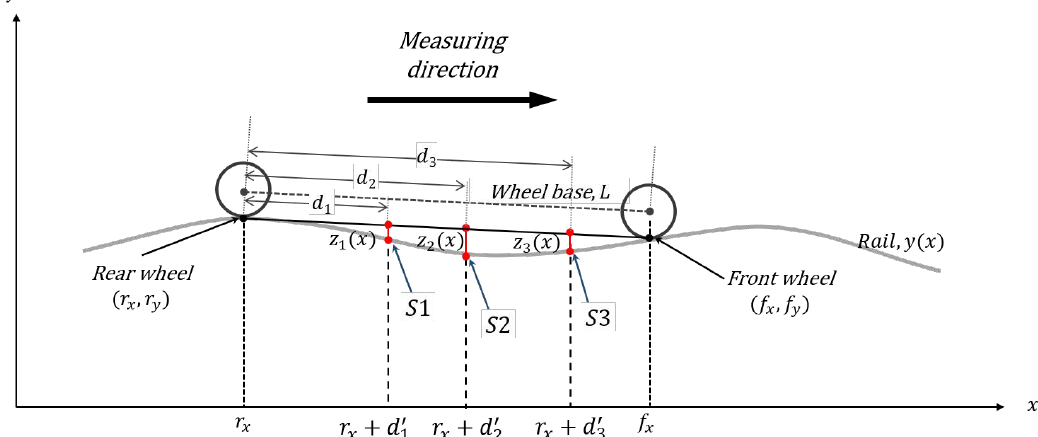
Figure 3. Multiple sensor-based chord offset measurement model, where α = d i / L i , d i is the distance between x r to i th sensor ( i = 1,2,3) (Adapted and modified from